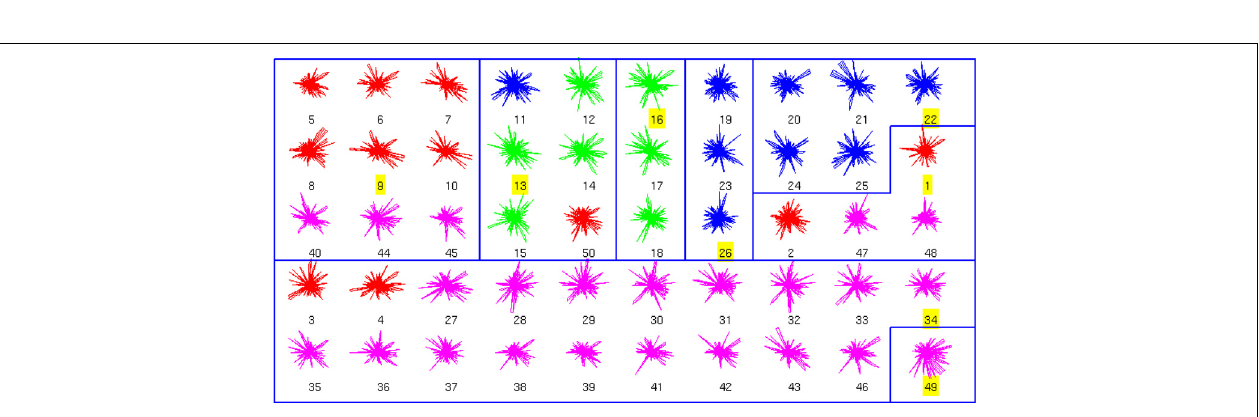
FIGURE 3 | Clusters of the combined Morphology + Physiology database. Code as in Figure 1 . See text for details on the